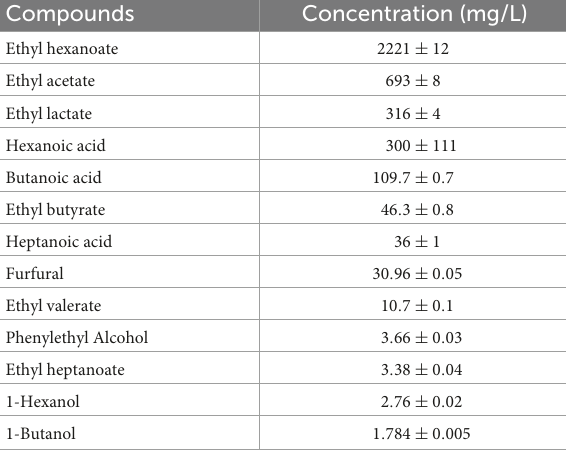
TABLE 3 Bioactive flavor compounds in baijiu and their beneficial effects.